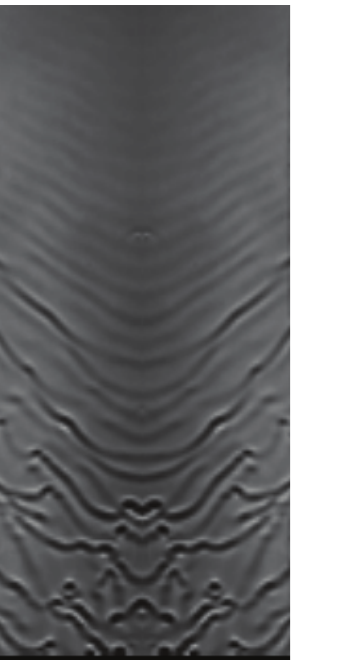
Figure 5: Two-dimensional regular wave packet, 𝛽 = 13 ∘ and Re = 56 .